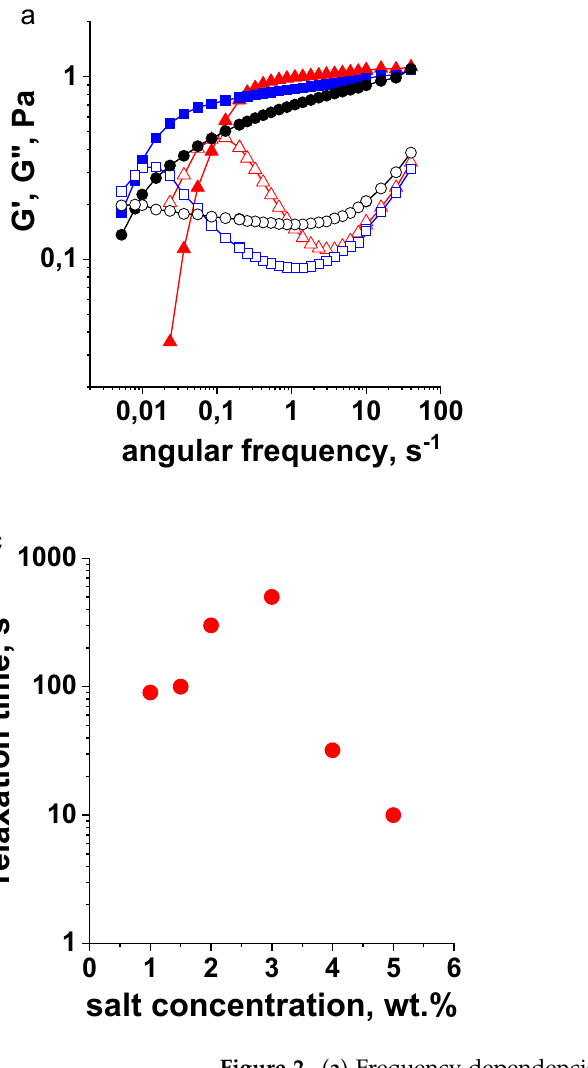
Figure 2. ( a ) Frequency dependencies of storage G (cid:48) (filled symbols) and loss G (cid:48)(cid:48) (open symbols) moduli for 0.8 wt.% aqueous solutions of EHAC surfactant in the presence of 1 wt.% (circles), 1.5 wt.% (squares), and 5 wt.% (triangles) KCl at 25 ◦ C. ( b ) Plateau modulus or storage modulus at high frequency (5 rad/s), ( c ) relaxation time, and ( d ) average contour length or effective contour length (for branched WLM) as a function of salt concentration for 0.8 wt.% aqueous solutions of EHAC surfactant. SANS was used to study the micelles’ structure and the intermicellar electrostatic interaction (structural factor). The measurements were carried out with 0.6 wt.% EHAC solution corresponding to semi-dilute regime. From the SANS curve (Figure 4), one can see that, at the low q region, the intensity decreases as q − 1 , which confirms the formation of WLMs in the solution [3]. From the middle part of the scattering curve, the local shape and size of the micelles can be obtained [21]. In Figure 4 (inset), ln(Iq) is plotted as a function of q 2 for the q-range 2 π / l p ≤ q ≤ 1/R g , where R g is the cross-sectional radius of gyration of WLMs of EHAC, and l p is their persistence length. The curve represents a straight line confirming local cylindrical shape of the WLMs. The gyration radius can be calculated (cid:112) from the slope as R g = 2 · tg α [2]. It was obtained that the R g = 2.1 ± 0.2 nm, and the cross-section radius R cs = 3.0 ± 0.3 nm. The last value is close to the length of